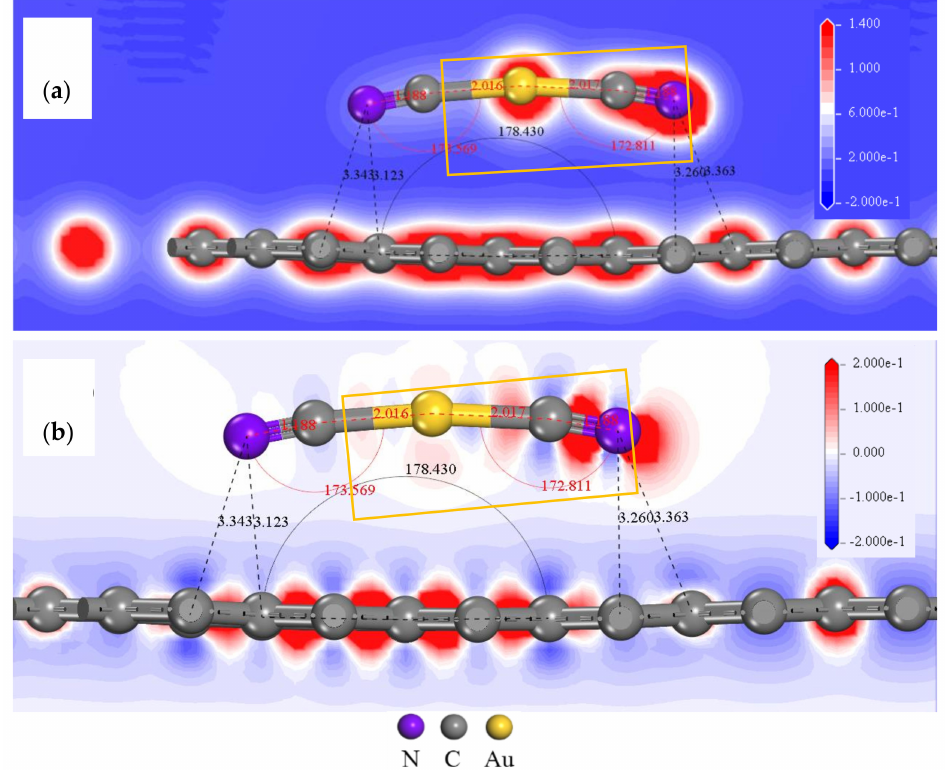
Figure 6. Charge density of the graphite stable adsorption configuration: ( a ) electron density, ( b ) electron density